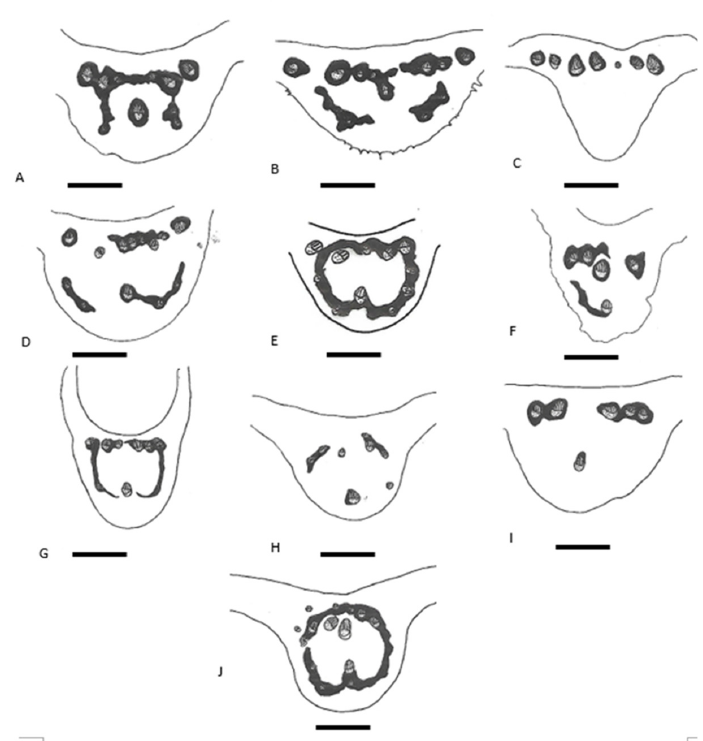
Figure 12. Transverse sections of midribs of Nepenthes species A, Nepenthes albomarginata . B, N. ampullaria. C, N. macfarlanei . D, N. mirabilis . E, N. benstonei . F, N. alba , G.